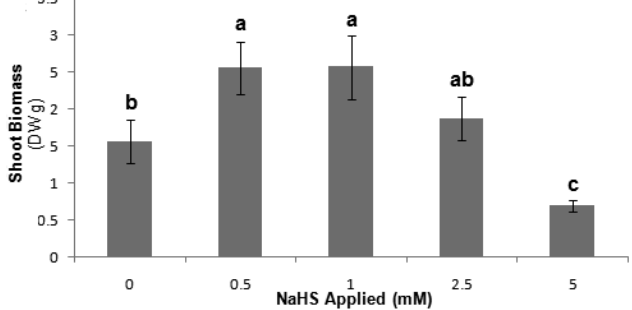
Fig. 1: Effects of different doses of NaHS on shoot biomass. Columns are mean ± S.E. ( n = 9 ). Different letters indicate significant difference between